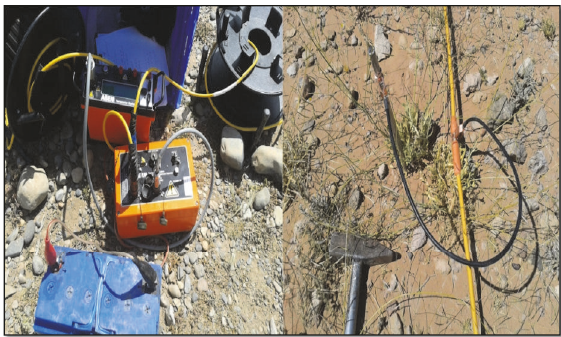
Figure 6: Instruments for the measurement of tomography.